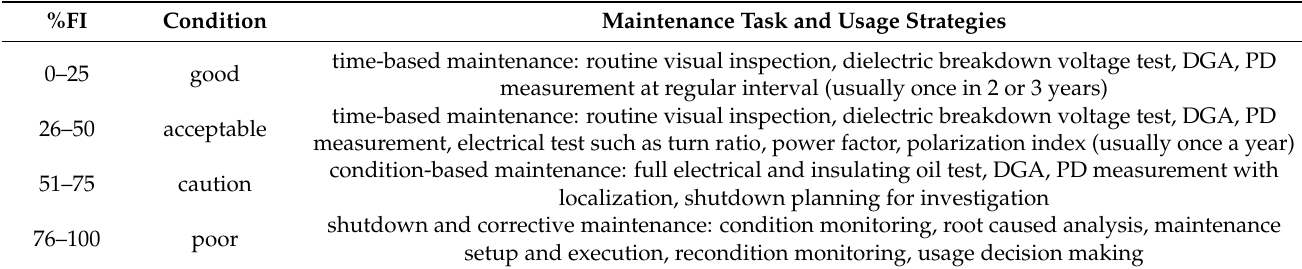
Table 17. Maintenance tasks and usage strategies corresponding to the accessed